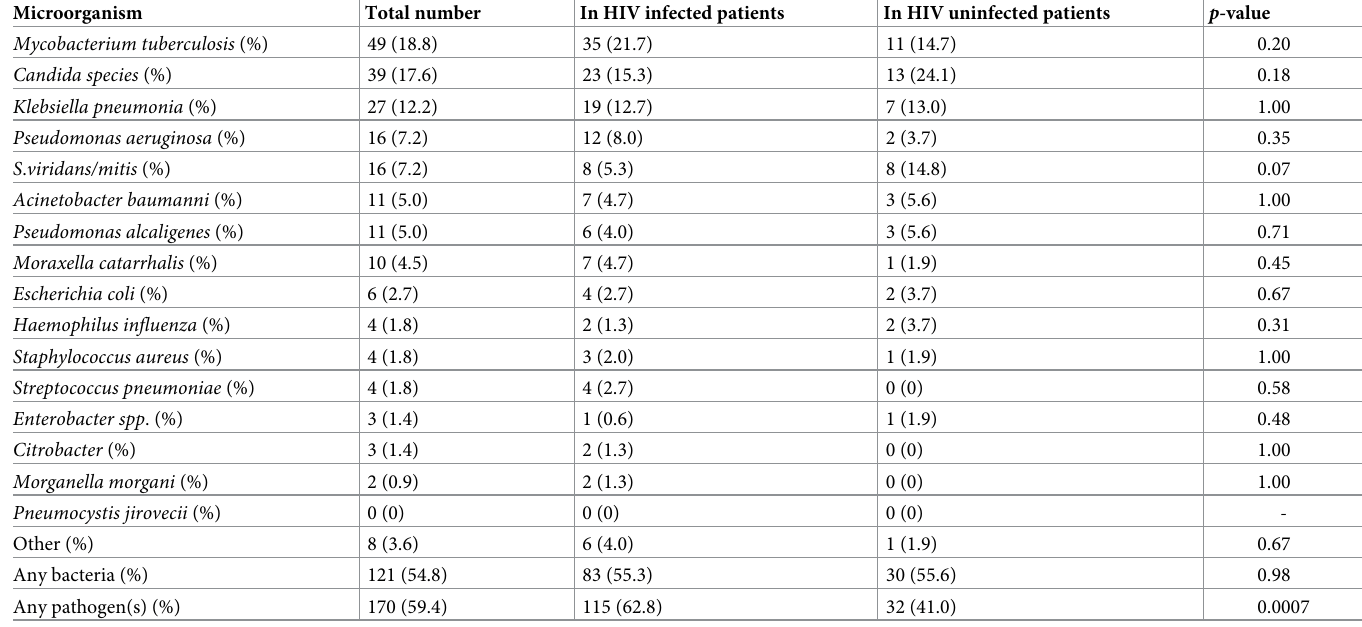
Table 2. Potential pathogens identified from sputum samples in patients with pneumonia.